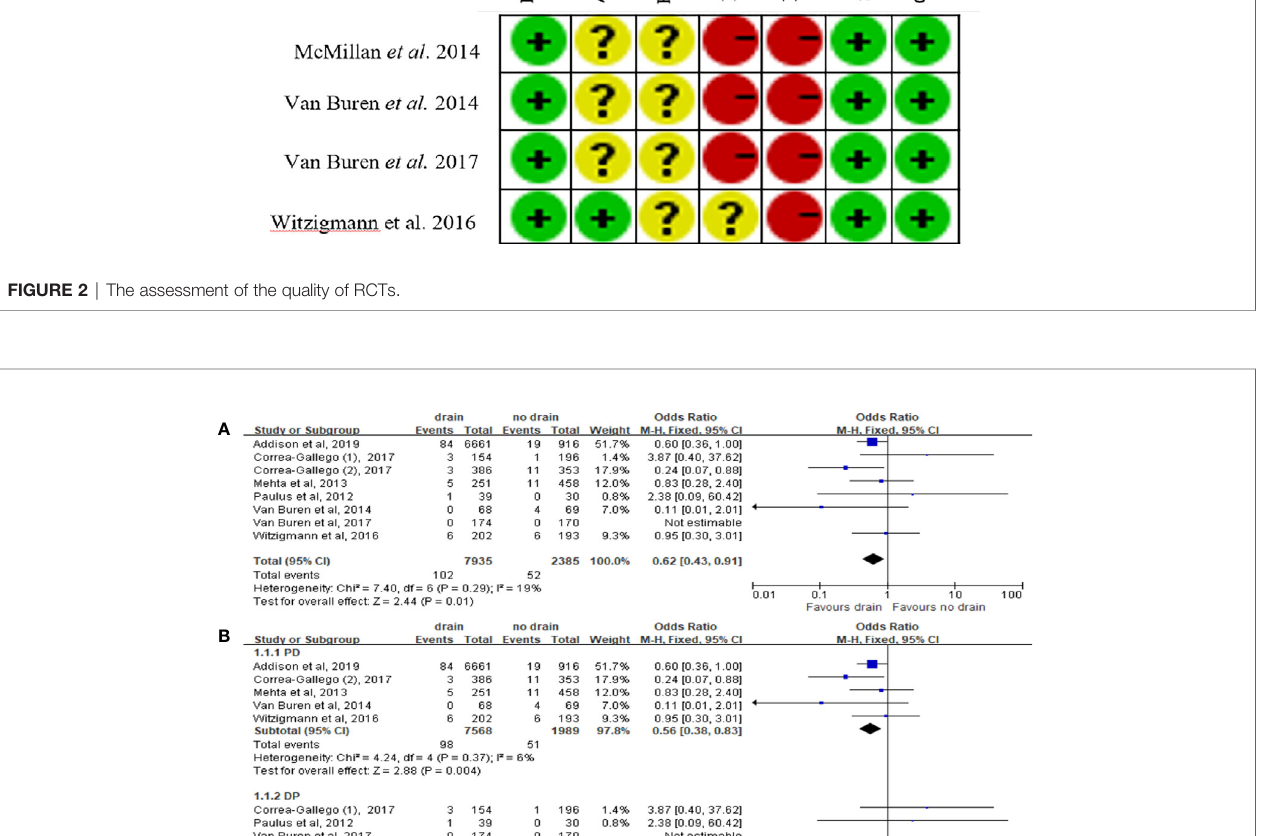
FIGURE 3 | Forest plot of the comparison of 30d-mortality in drain versus no-drain groups after pancreatic resection. (A) Comparison in overall; (B) comparison in PD and DP subgroups,